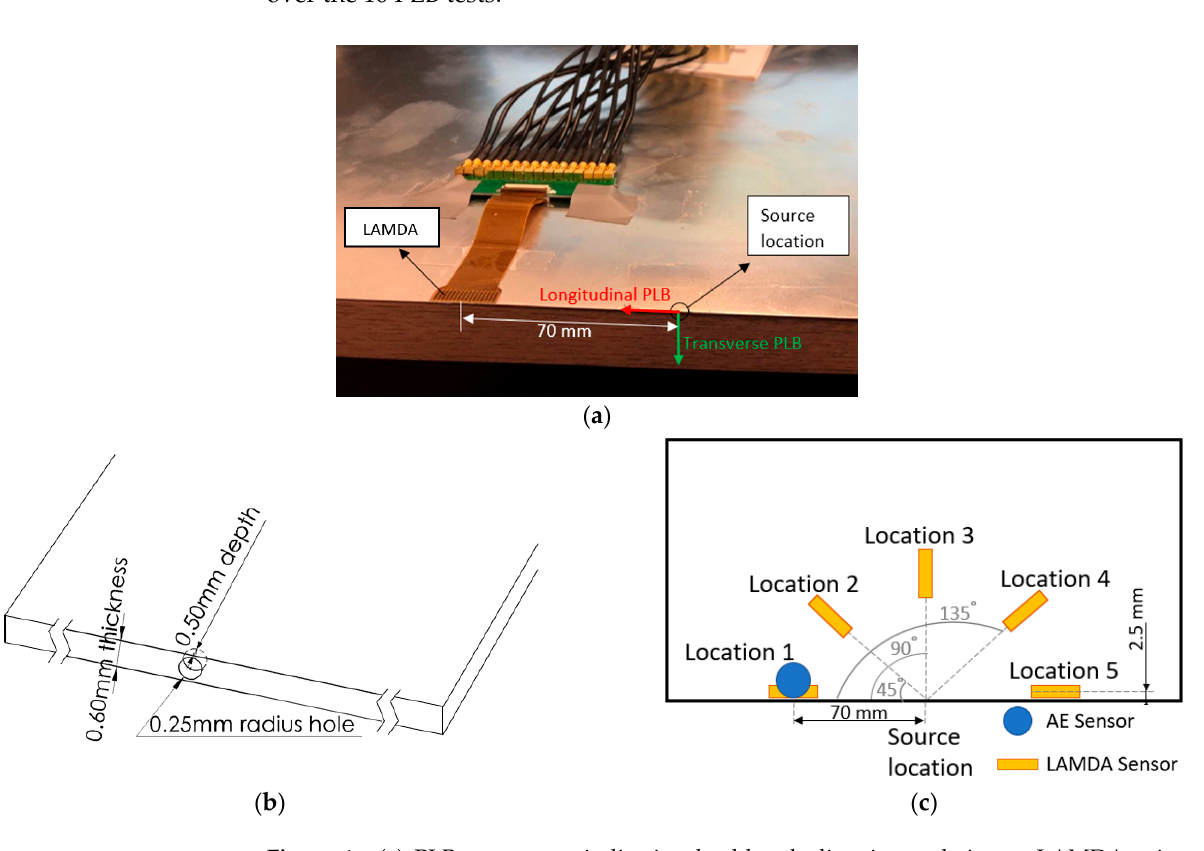
Figure 1. ( a ) PLB test set-up indicating lead-break directions relative to LAMDA orientation; ( b ) schematic showing PLB hole dimensions; ( c ) sensor locations relative to source.